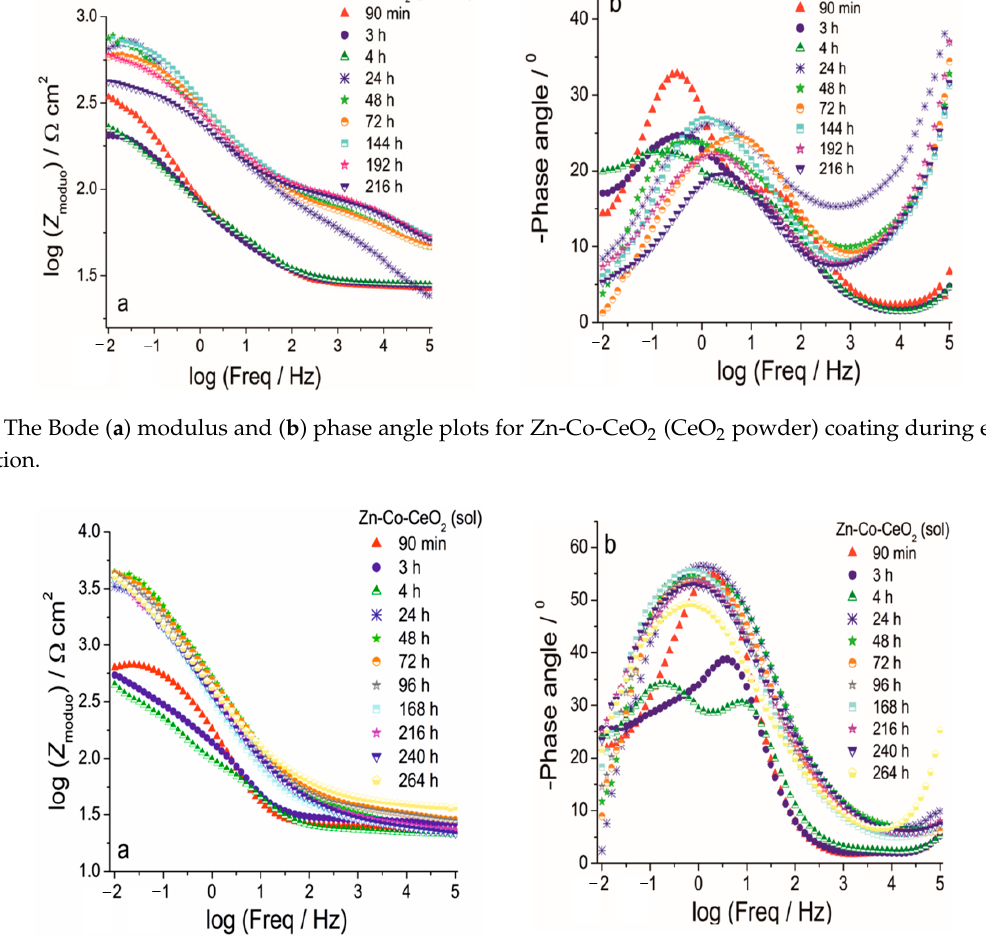
Figure 12. The Bode ( a ) modulus and ( b ) phase angle plots for Zn-Co coating during exposure to NaCl solution.